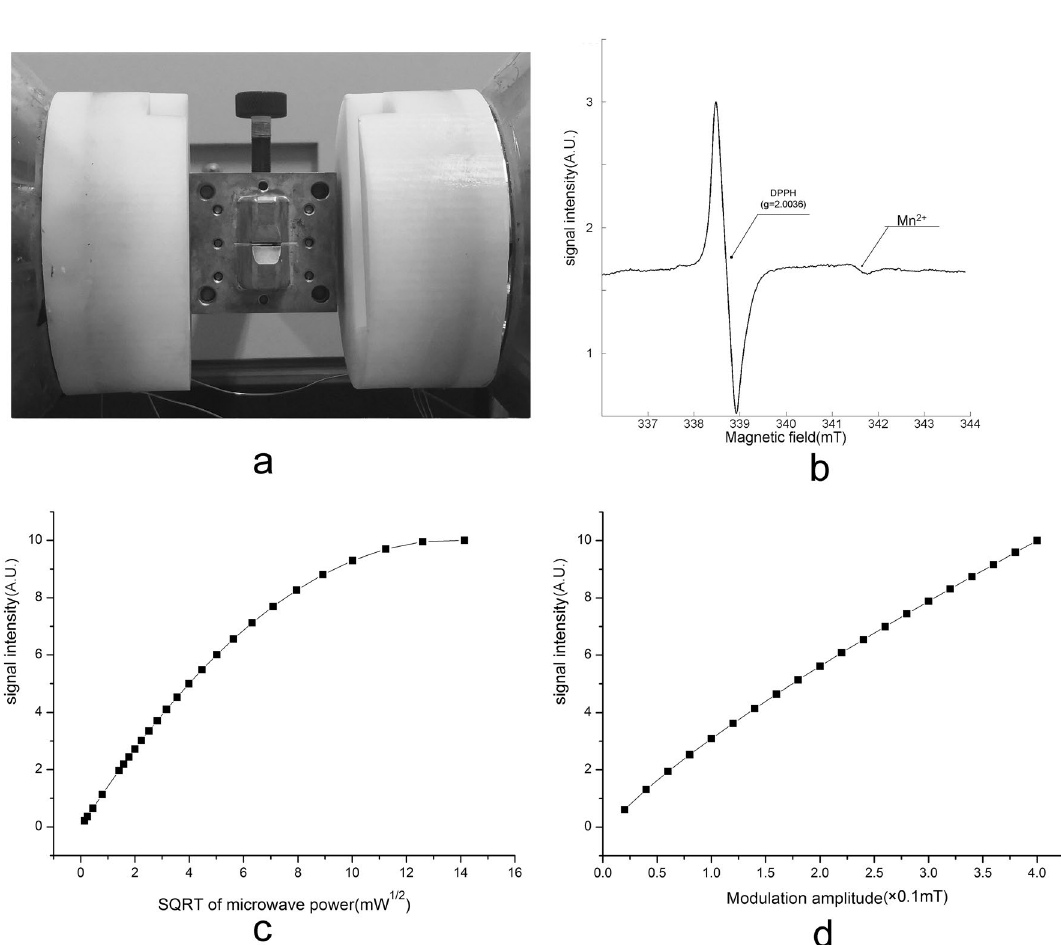
Figure 4. Result of EPR spectroscopy of a DPPH dot sample. ( a ) The DPPH sample inserted into the detection aperture of the cavity in the measuring status. ( b ) A typical EPR spectrum of the DPPH sample. ( c ) The relative signal intensity of the EPR spectra against the square root of power. ( d ) The relative signal intensity of the EPR spectra against the modulation